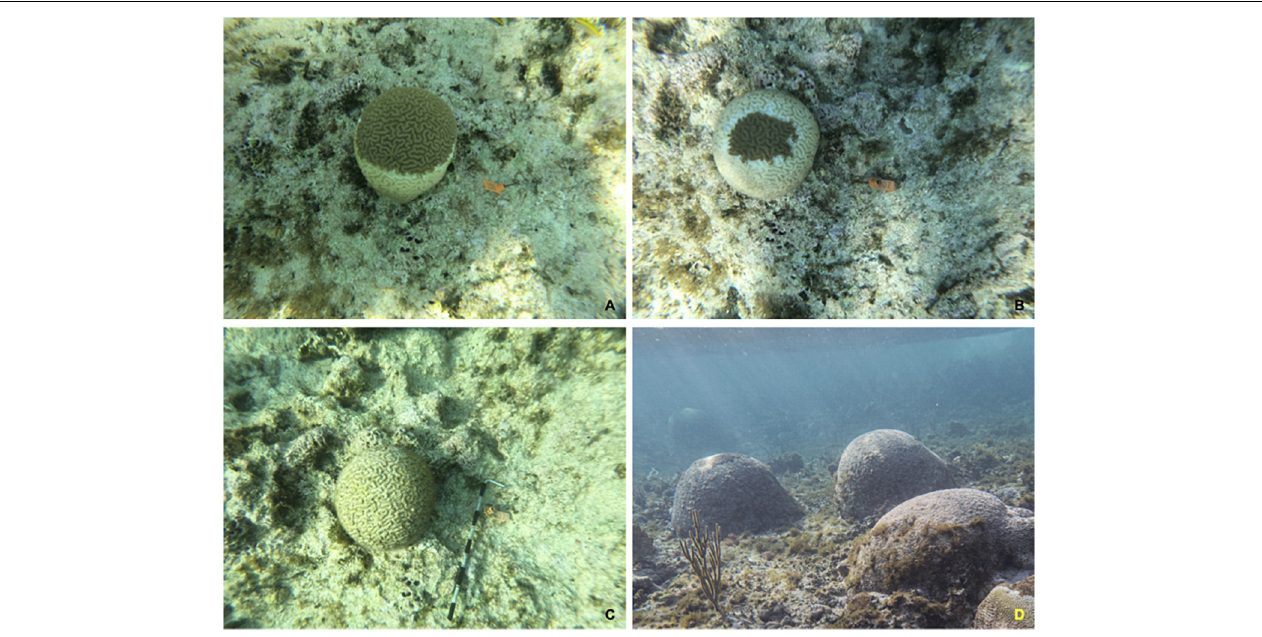
FIGURE 1 | Time series of a P. strigosa colony infected with stony coral tissue loss disease (SCTLD) from November 8, 2019 (A) to November 27, 2019 (B) before transitioning to recent mortality by January 16, 2020 (C) . A reef with widespread mortality of P. strigosa is also shown from 2021 (D)